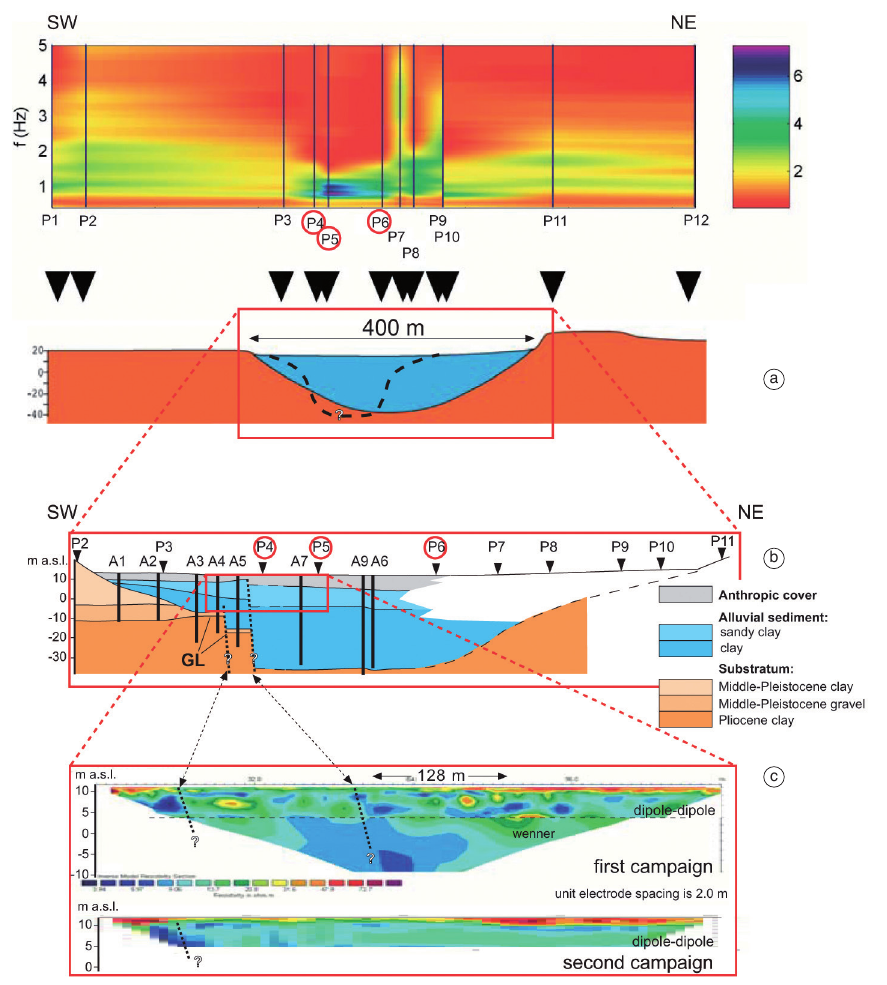
Fig. 4a-c. a) Results of the seismic noise measurements from the INGV seismic array at the Grottaperfetta site (see fig. 3 for location of the seismic stations) showing the amplification frequencies of the H/V ratio across the valley. The dashed line in the inferred geological cross-section evidences the asymmetric shape of the valley, as suggested from the position of the highest peaks along the section. b) Schematic geological reconstruction of the asymmetric valley based on acquired stratigraphic logs of boreholes (see fig. 3 for locations). c) Inversion from geoelectrical profile across the valley (for location see blue line in fig. 3) performed with different arrays. The second campaign provided more reliable data for the upper portion of the alluvial fill. Black dotted lines are positioned where lateral variations of the resistivity of the sediments are suggestive of the presence of a